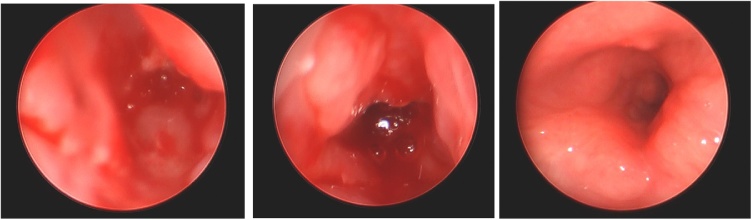
Images – Flexible Laryngoscopy with Visualization of the Nasopharynx and Oropharynx.